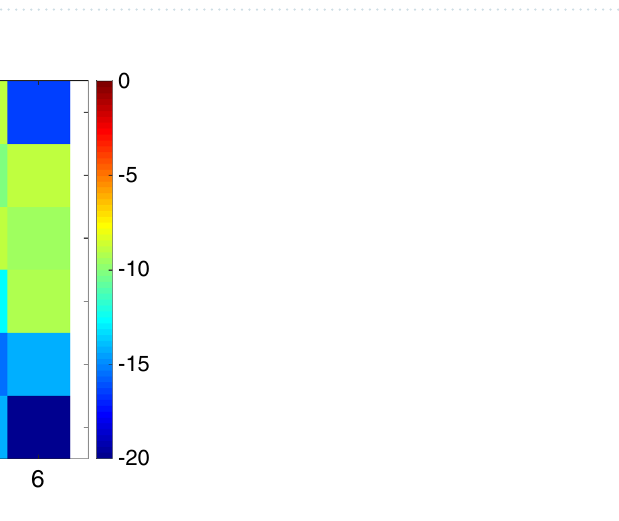
Figure 7. Photograph of the proposed 6-channel flexible coil unrolled with ( a ), without ( b ) the protective cover, and wrapped around a cylindrical phantom ( c ).